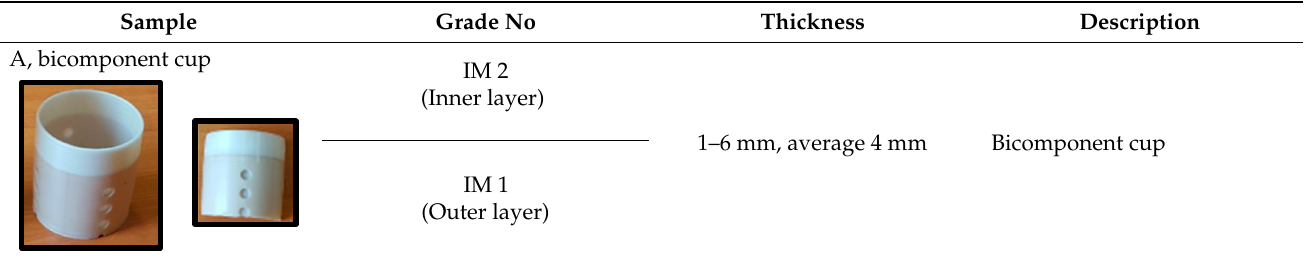
Table 2. Products that were tested for biodegradation and compostability.